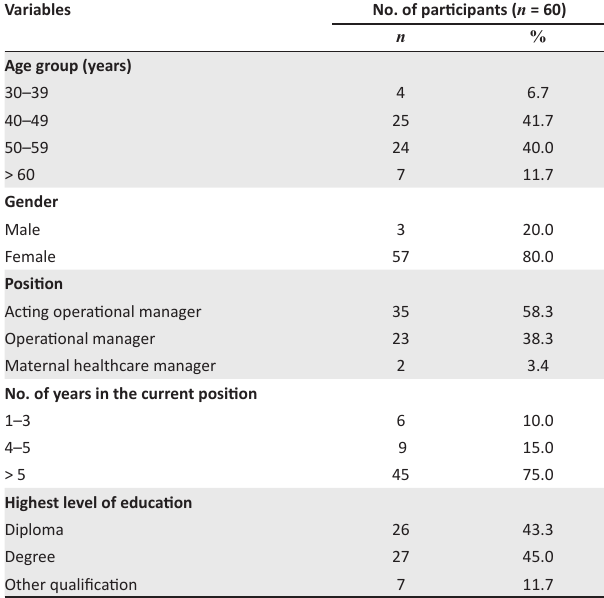
TABLE 1: Demographic characteristics of